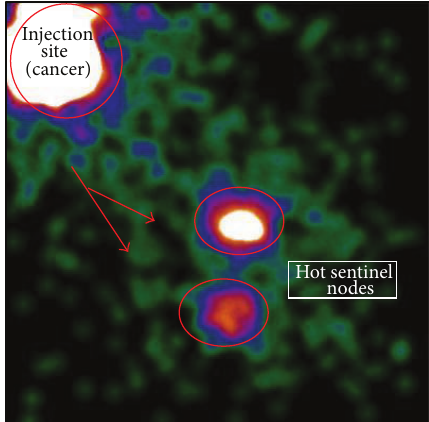
Figure 1: Intraoperative lymphoscintigraphy of patient with non- palpable left breast cancer 3 hours after peritumoral injection of radiotracer ( 99 m TC-labelled human albumin microcolloid). Ante- rior view shows 2 axillary sentinel nodes.